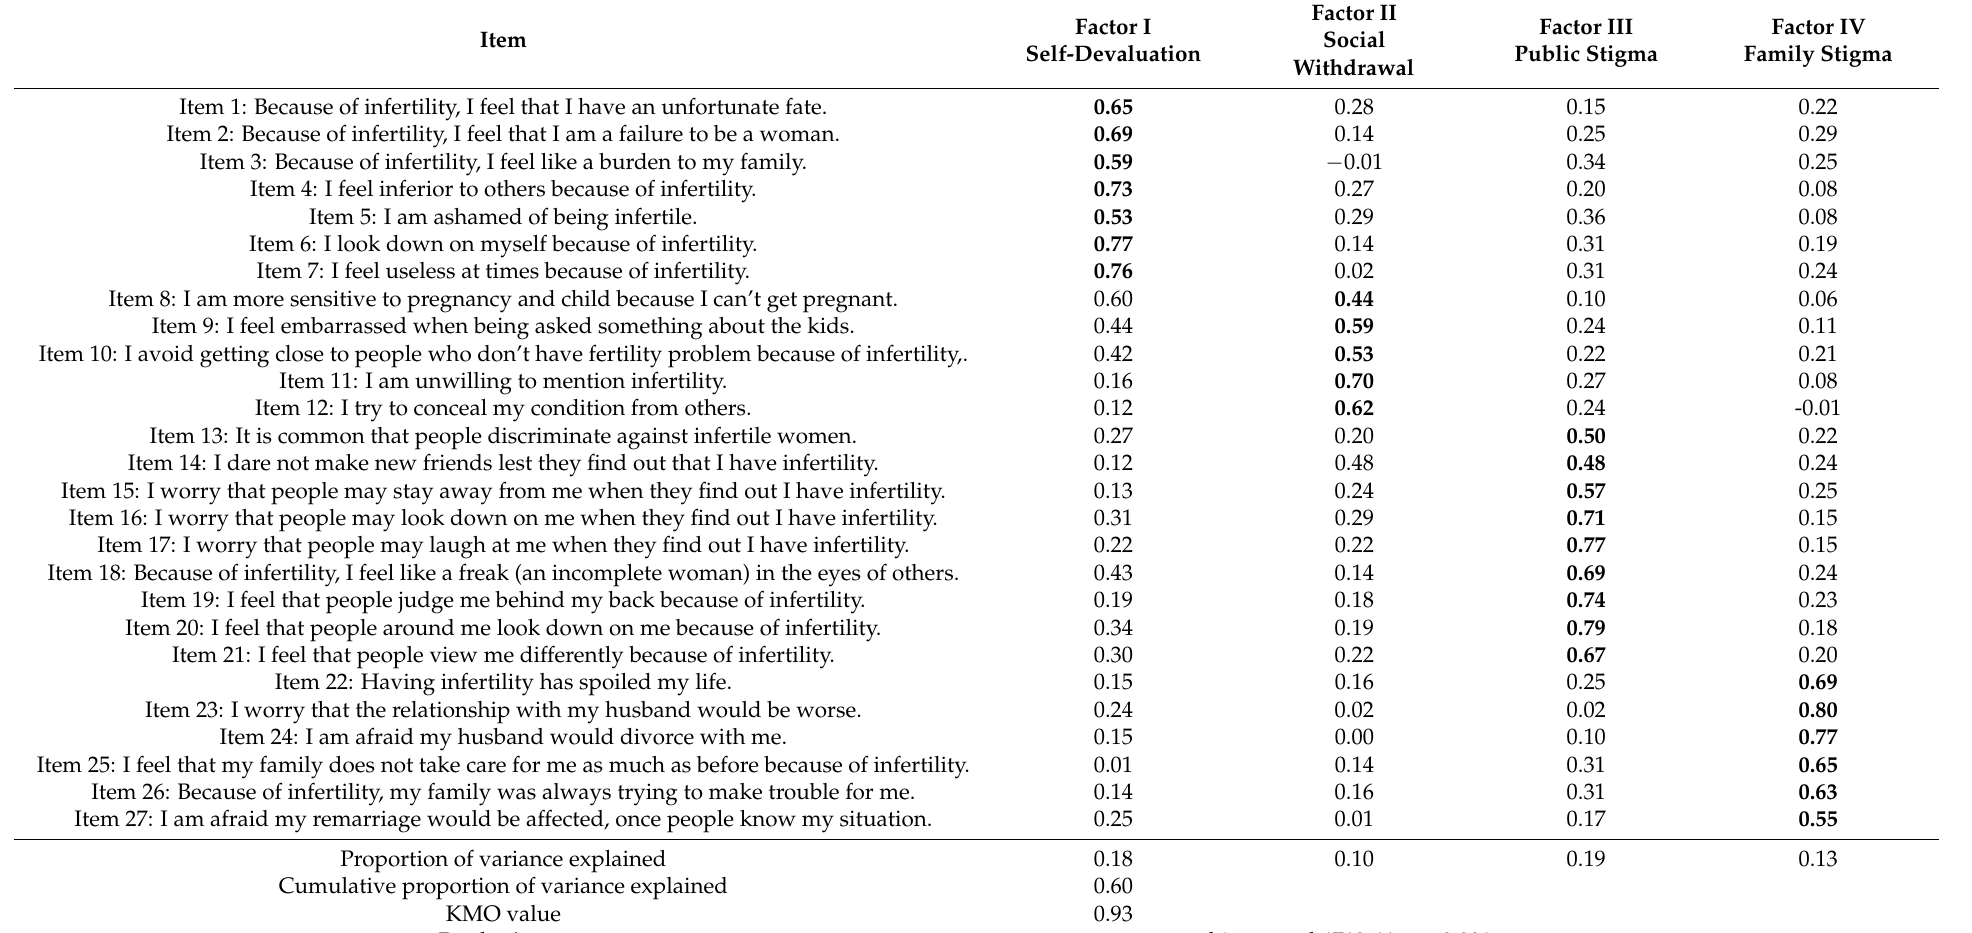
Table 2. Factor loading values of the ISS items ( N = 254). Item